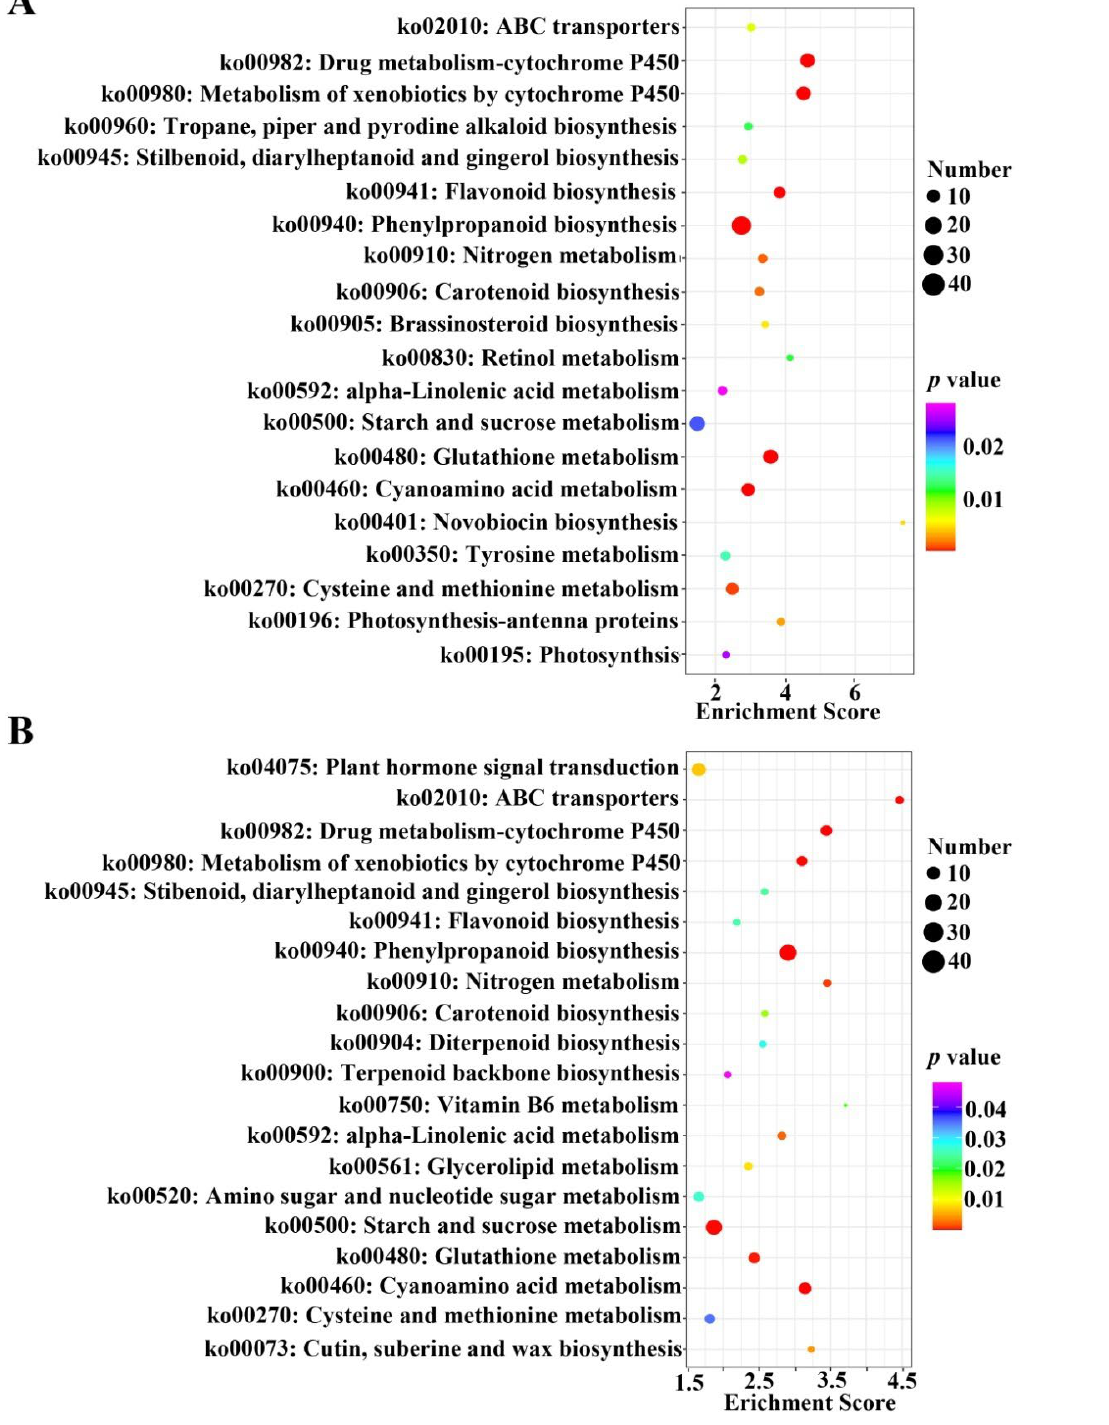
Figure 4. KEGG pathway enrichment analysis of significantly up- and down-regulated DEGs. ( A ) Enriched KEGG pathways of DEGs identified from S versus M treated by KCL (KCL_S vs. KCL_M). ( B ) Enriched KEGG pathways of DEGs identified from S versus M treated by KNO 3 (KNO 3 _S vs. KNO 3 _M). The size of the circle represents the number of DEGs in that KEGG pathway, and the color of the circle indicated p value.